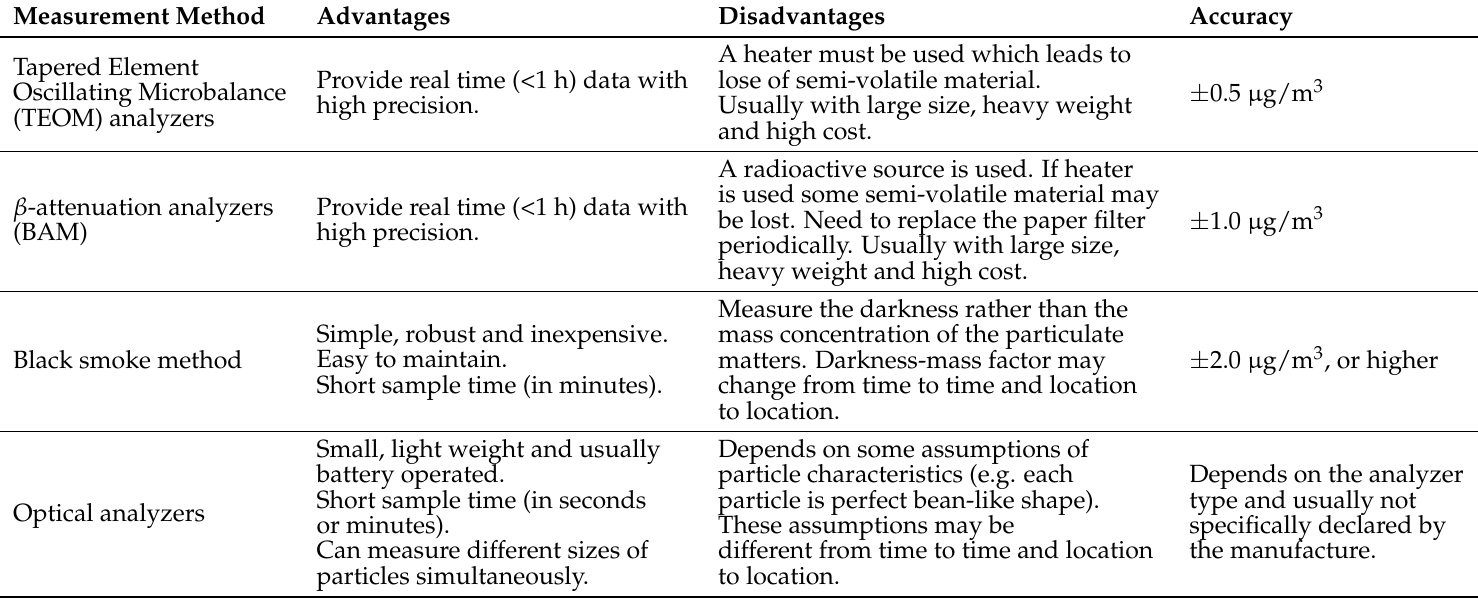
Table 8. Comparison of four types of particulate matter (PM) measurement